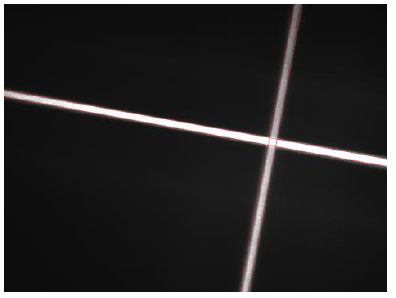
Figure 9. Edge line extraction result.